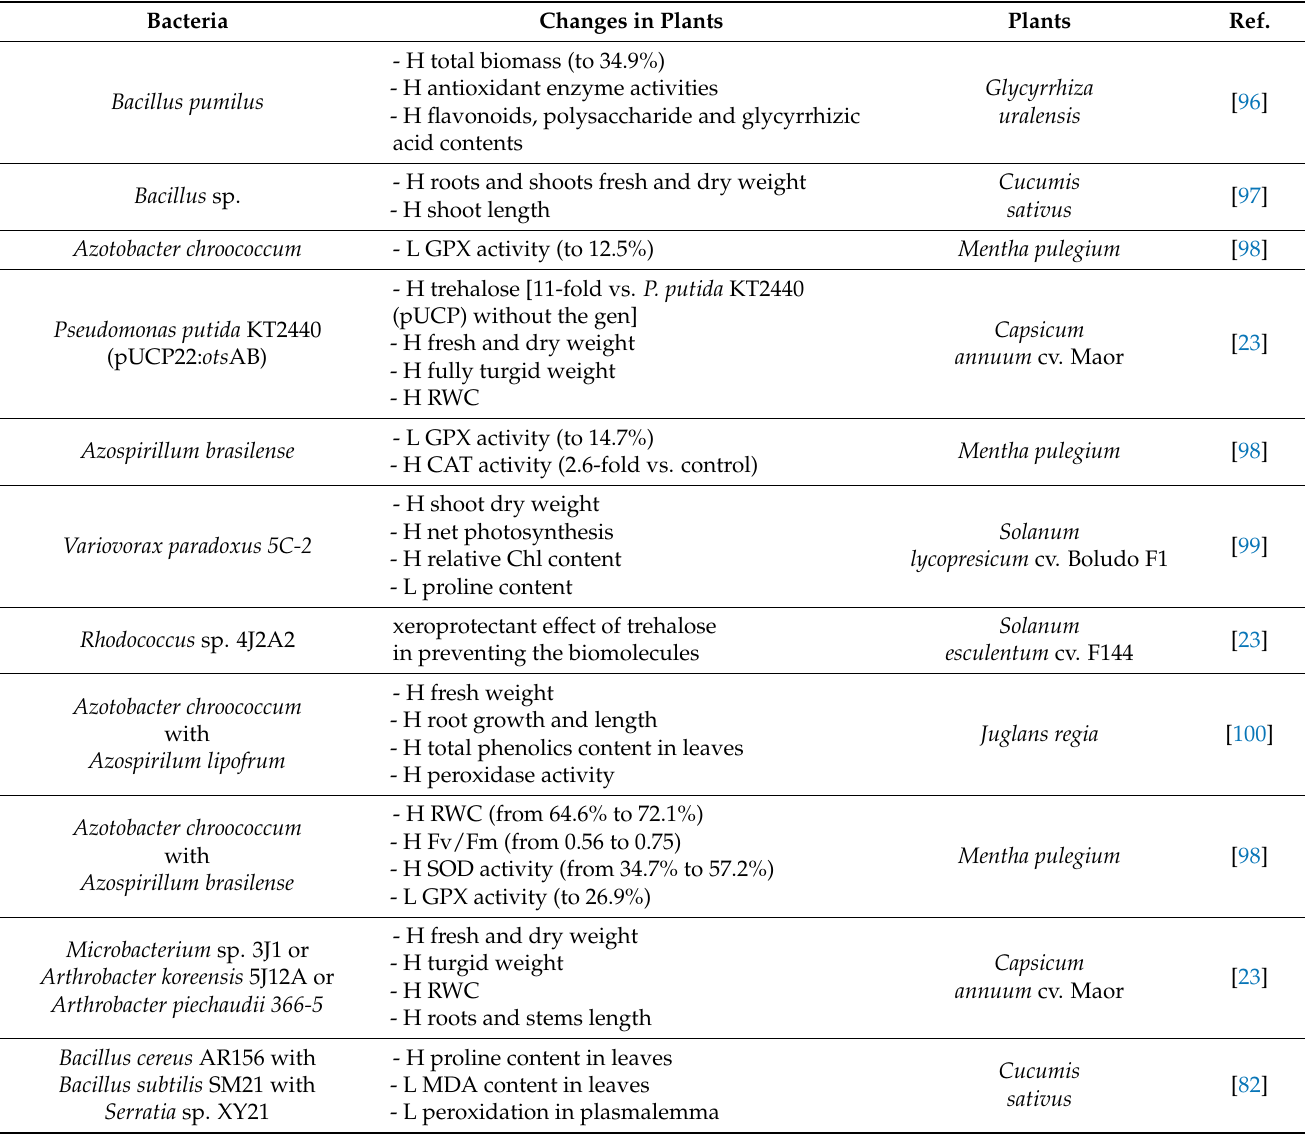
Table 1. Selected activities of beneficial bacteria under drought-stress conditions in horticultural plant species; H—higher level/content; L—lower level/content; GPX—glutathione peroxidase; CAT—catalase; Chl—chlorophyll;